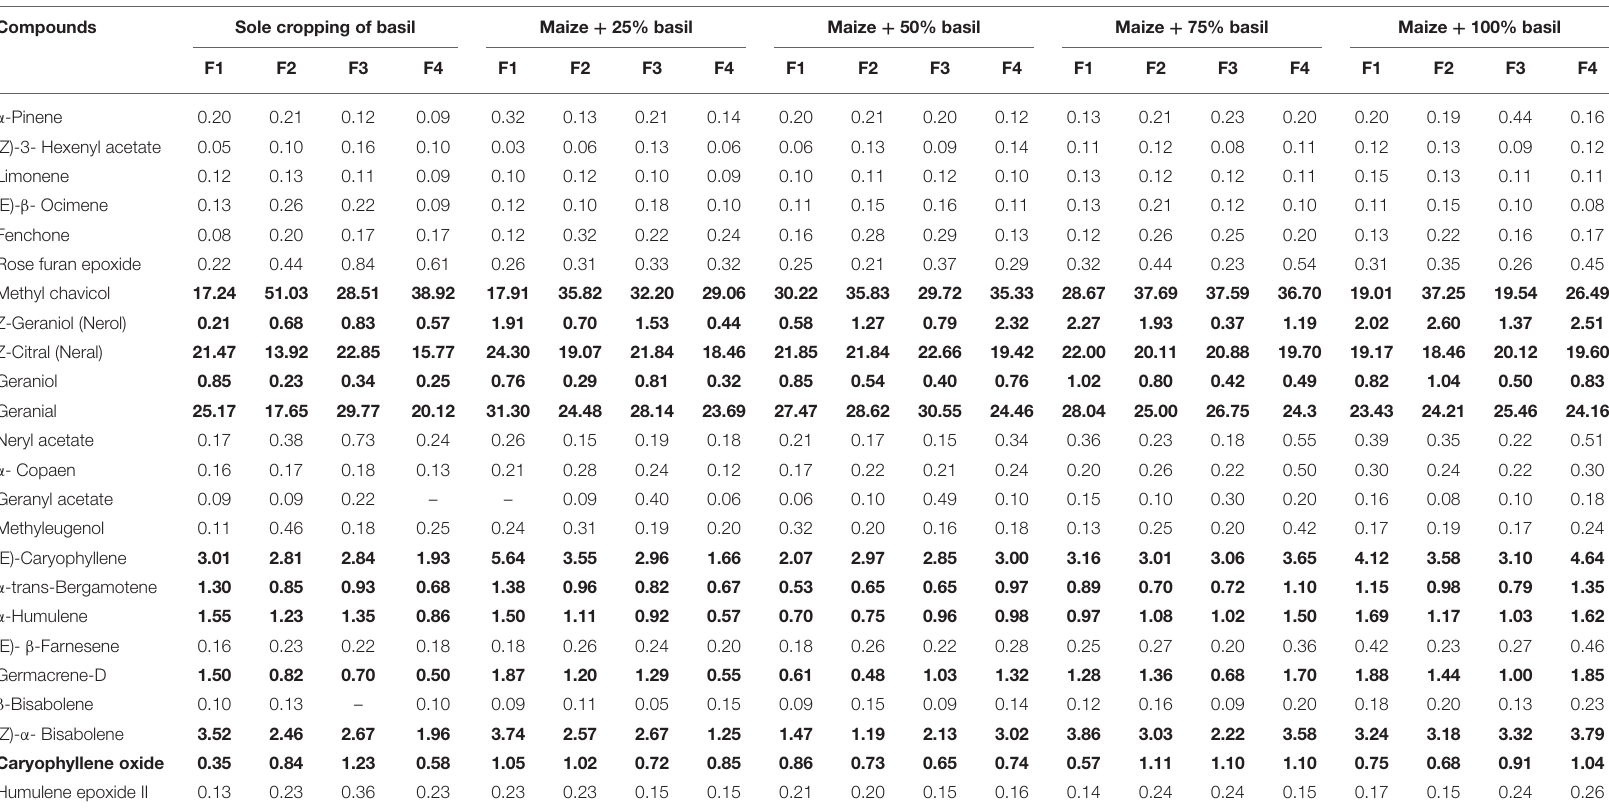
TABLE 4 | Essential oil constituents in basil grown with different sources of nitrogen under different patterns of cropping during 2018 growing season (expressed on relative percentage basis).